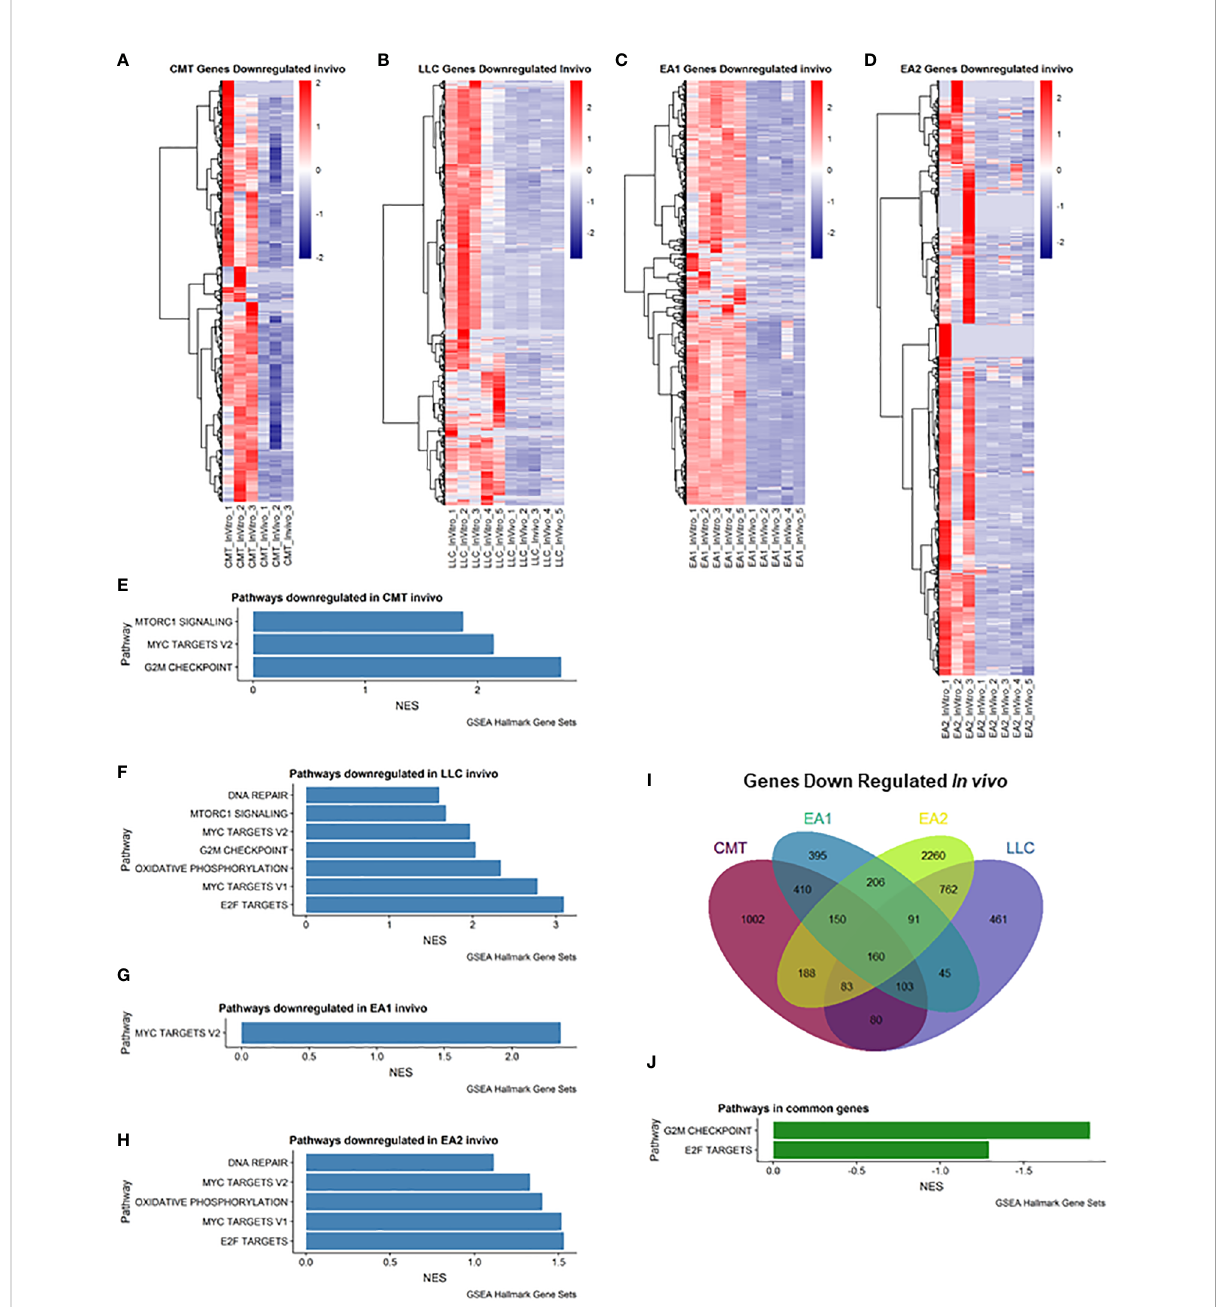
FIGURE 2 Analysis of genes downregulated in vivo compared to in vitro cells. (A – D) : Heatmap of genes differentially downregulated in cells recovered from tumors ( in vivo ) compared to cells grown in culture ( in vitro ) for each of the cell lines: (A) CMT167, (B) LLC, (C) EA1, (D) EA2. Gene set enrichment analysis of pathways of Hallmark Gene Sets shows pathways downregulated in vivo compared to in vitro cells in CMT167 cells (E) , LLC cells (F) , EA1 cells (G) , and EA2 cells (H) . (I) Venn diagram shows genes commonly and/or differentially upregulated in all tumor types. (J) shows the common pathways upregulated in all 4 tumors. Differentially expressed genes were de fi ned as being in the leading edge of the GSEA and had a rank score of less than -1, and the FPKM value had to be greater than